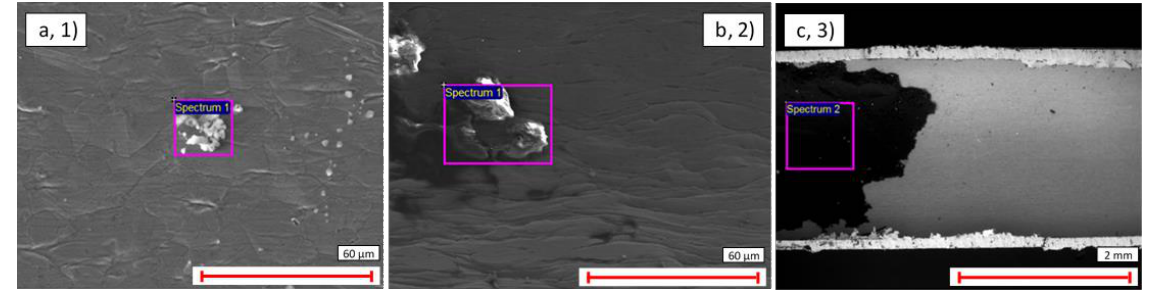
Figure 7. SEM image of contamination on: ( a ) CuNi thin-walled pipe (1); ( b ) SS thick-walled pipe (2); ( c ) Ti with Ni-coated thin-walled pipe (3). Table 6. Internal surface EDX compositions from box scans of identified contamination zones.